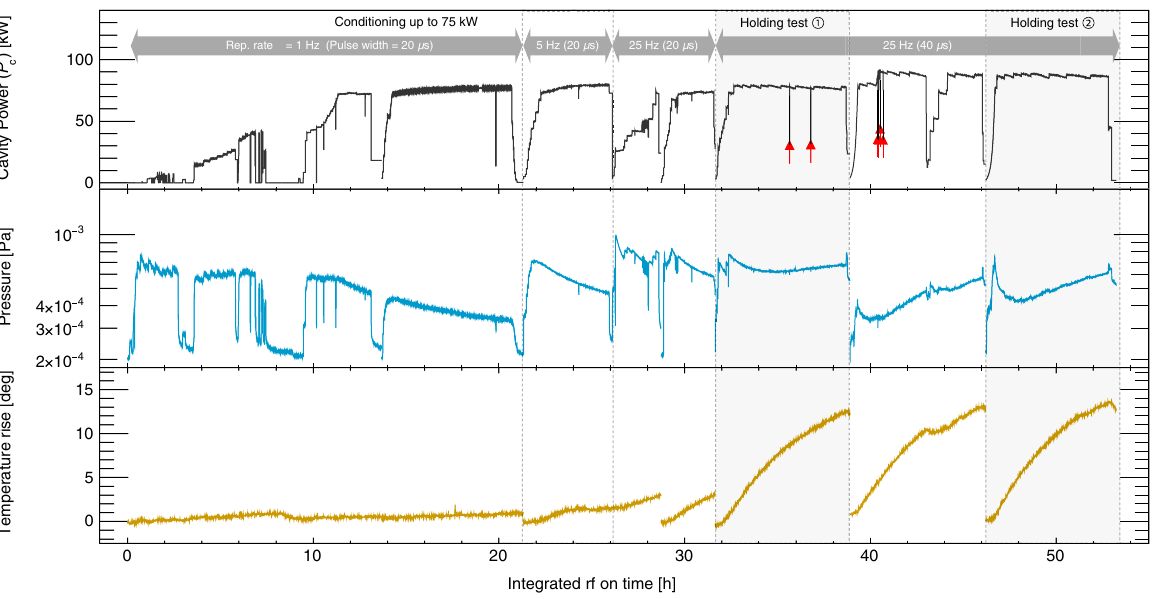
FIG. 12. Conditioning history of the short IH. The red arrows in the top plot indicate the cavity trip caused at the nominal duty factor. The temperature data show the difference between the average of the three thermocouples and the ambient temperature. The surface temperature of the cavity was measured at three different locations and showed no dependence on